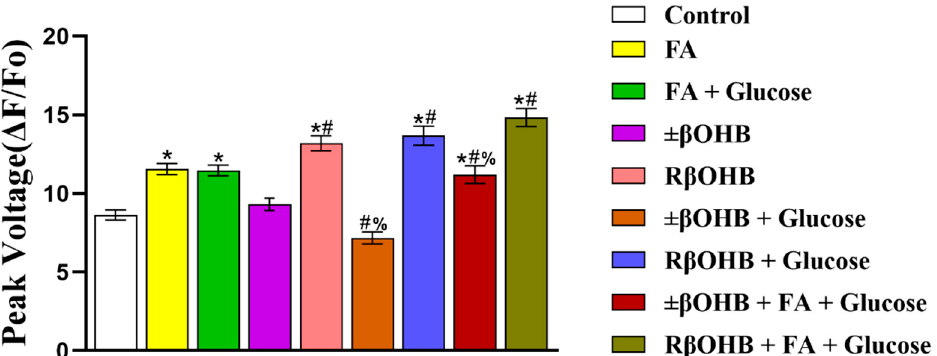
Figure 3. Quantification of FluoVolt optical AP amplitudes recorded from iPS-CMs cultured in various media. Peak voltage under control media, fatty acid media, fatty acid + glucose media, ± β OHB, R β OHB, ± β OHB + glucose media, R β OHB + glucose, ± β OHB + FA + glucose media, or R β OHB + FA + glucose media treatment. * p < 0.008 vs. control. # p < 0.008 vs. ± β OHB. % p < 0.008 vs. R β OHB.